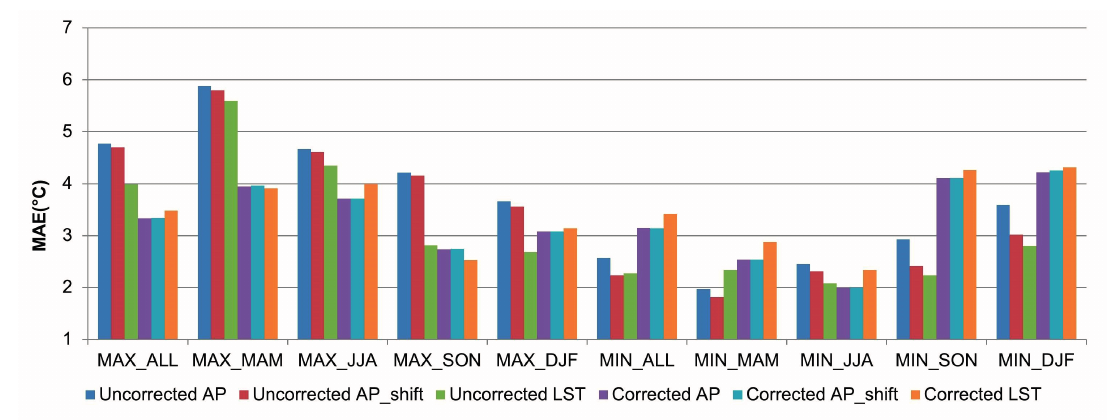
Figure 3. MAE values averaged for 60 ASOS weather stations’ locations for estimating daily air temperature with or without the correction using the NCEP/NCAR reanalysis data (unit: °C).